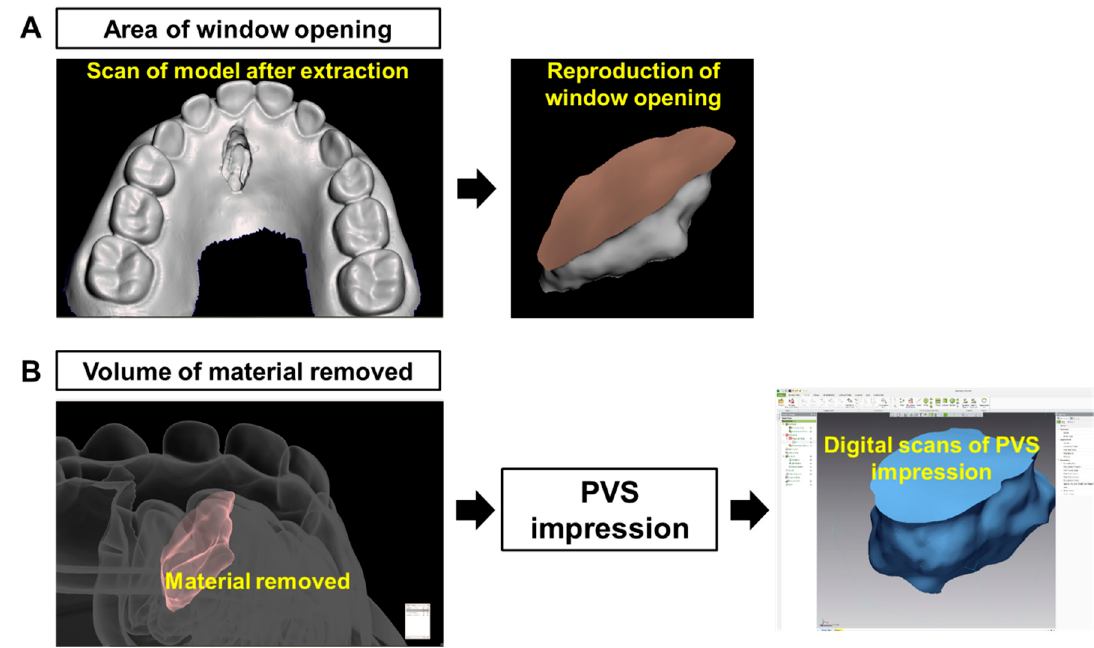
Figure 3. Digital measurements of the area of the window opening and 3D volume of the material removed. ( A ) Digital scans of models obtained after supernumerary tooth extraction and of the window opening were reproduced. The area of the window opening was calculated using 3D analysis software. Note that the brown circle indicates the extent of the window opening. ( B ) 3D volume of the material removed was measured by a polyvinylsiloxane (PVS) impression of the inner surface of the model.